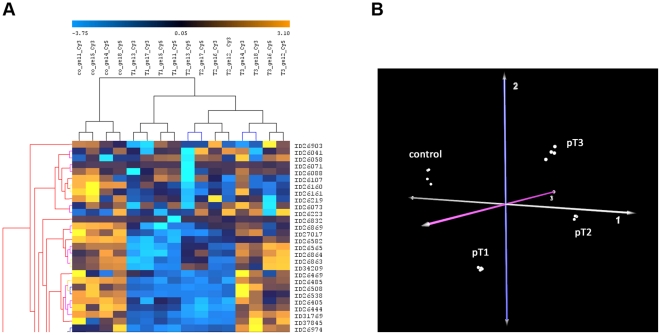
Hierarchical clustering and Principal Component Analysis.Principal component analysis can separate normal and tumor tissue. A Partial representation of the unsupervised clustering (Euclidean Distance measure and the ‘average’ linkage) was performed using the log transformed expression protein values of 16 samples (quadruple replicates of control, pT1, pT2 and pT3). The samples are shown vertically, the spots horizontally indicated by ID numbers. The dendrograms represent the distances between the clusters. High expressions are coloured orange, the lower ones in blue. B 3D-plot of the first three principal components of PCA from the protein expression data separates all analyzed samples. Each point represents one sample with different replicates and dye swap, distribution of information with respect to differential expression between tumor stages and control tissues. The output of the model indicates the existence of 4 classes differing significantly according to their separability. They fitted to the analyzed sample groups: control, pT1, pT2 and pT3.